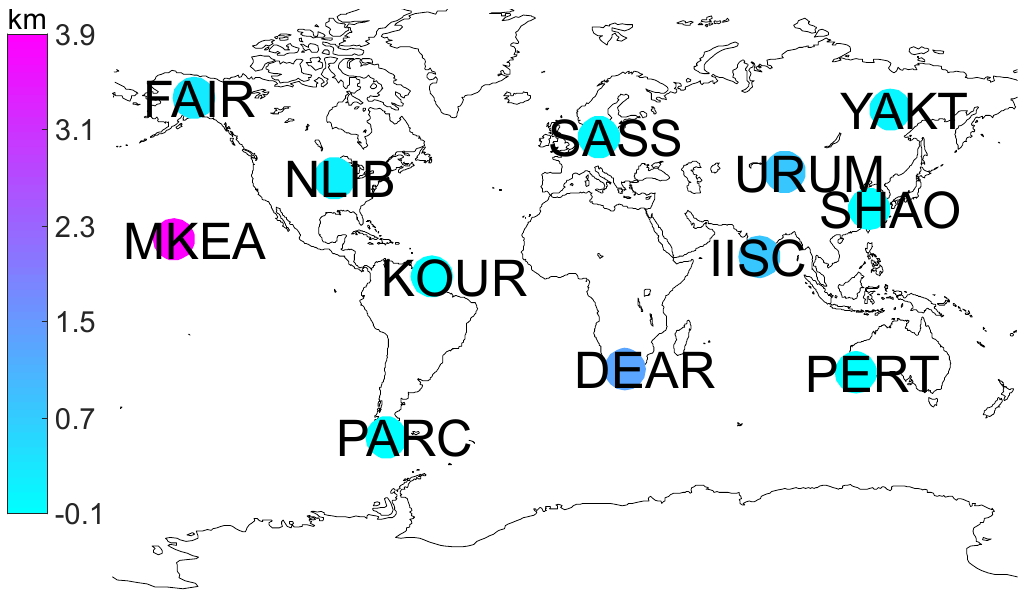
Figure 3. Distribution of the IGS stations used, the color of a circle denotes the station’s height. Please note that each dot only represents the position of a station, and there is no meaning for its size here.